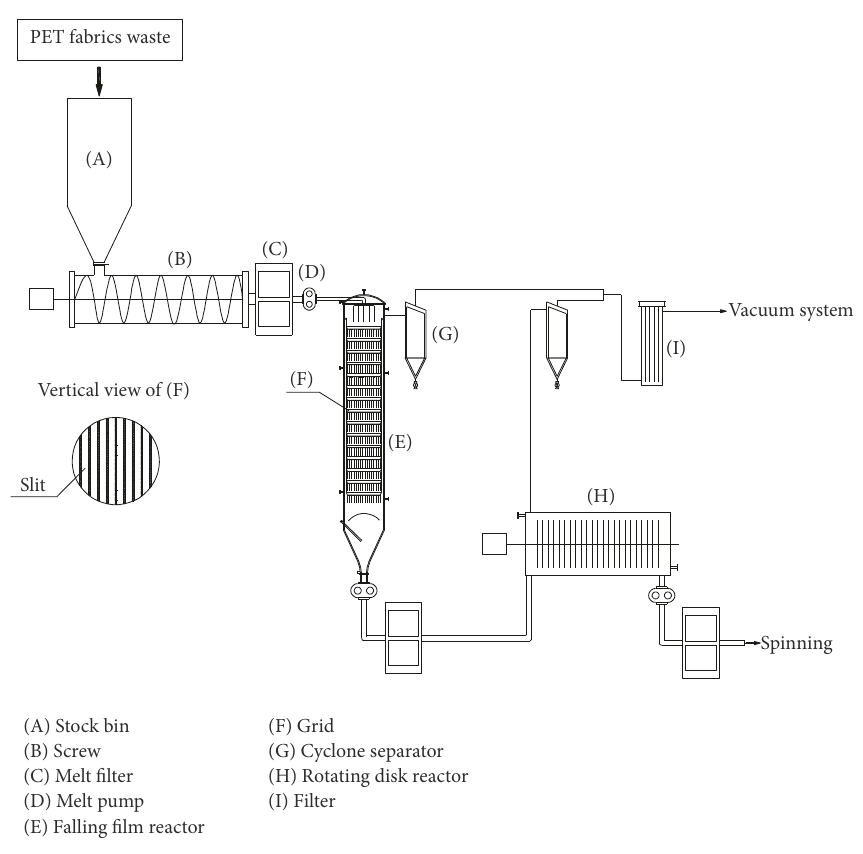
Figure 1: Schematic of the falling film-rotating disk combined reactor.